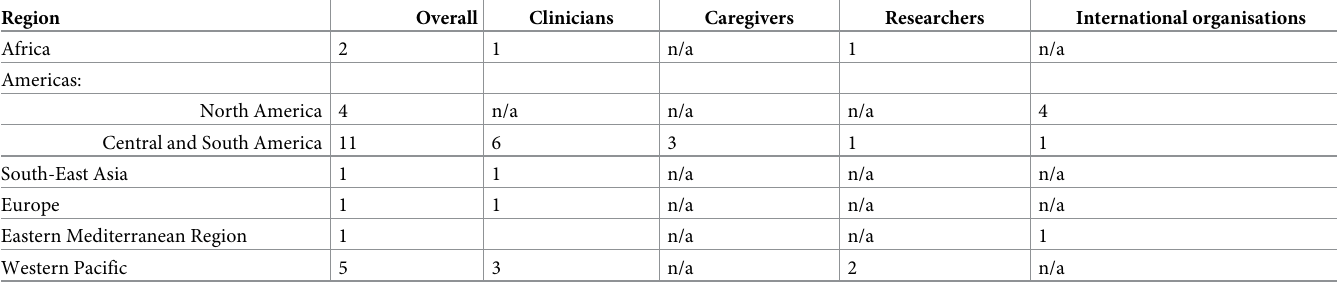
Table 2. Characteristics of participants in the semi-structured interviews.